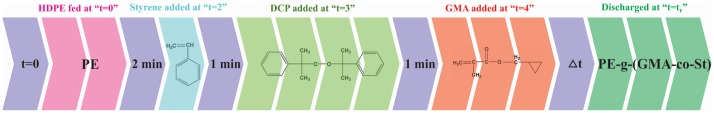
 Time schedule applied in melt grafting of GMA on HDPE.